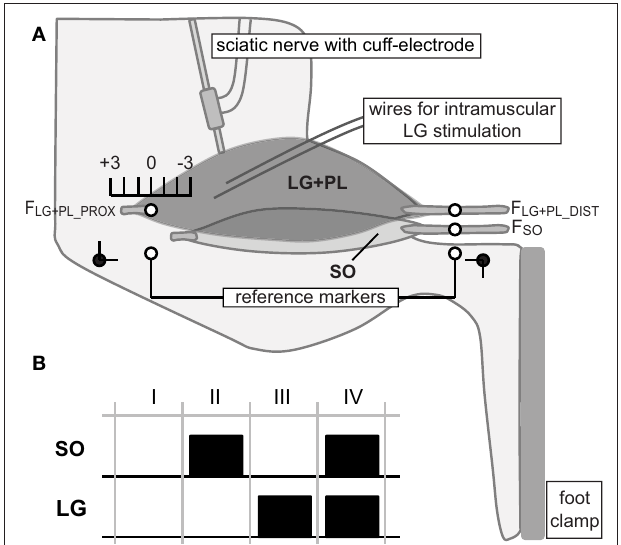
FIGURE 1 | Experimental set-up and protocol. (A) Lateral view of the rat hindlimb in the experimental set-up with knee and ankle angle (black dots) at 90 ◦ . Proximal and distal tendons of lateral gastrocnemius and plantaris (LG + PL), as well as distal soleus (SO) tendon were connected to force transducers (F LG + PL_PROX , F LG + PL_DIST and F SO , respectively). The origin of the proximal SO tendon onto the skeleton was kept intact. SO was excited via a cuff electrode around the sciatic nerve. LG was excited via intramuscular fine wire electrodes. Proximal and distal reference markers were placed on the lateral collateral ligament and distal tendon of the peroneus muscle, respectively. Markers on the distal SO tendon, distal LG tendon and proximal LG aponeurosis were placed parallel to those markers. Distal markers of SO and LG were kept at reference position. Knee extension was simulated by changing the muscle-tendon unit (MTU) length of the LG + PL complex proximally from − 3 mm to + 3 mm relative to the reference position (90 ◦ ankle and knee angles). (B) Different muscle excitation protocols used in the present study. For each LG + PL MTU length, SO and LG muscles were either passive (I), excited separately (II and III) or excited simultaneously